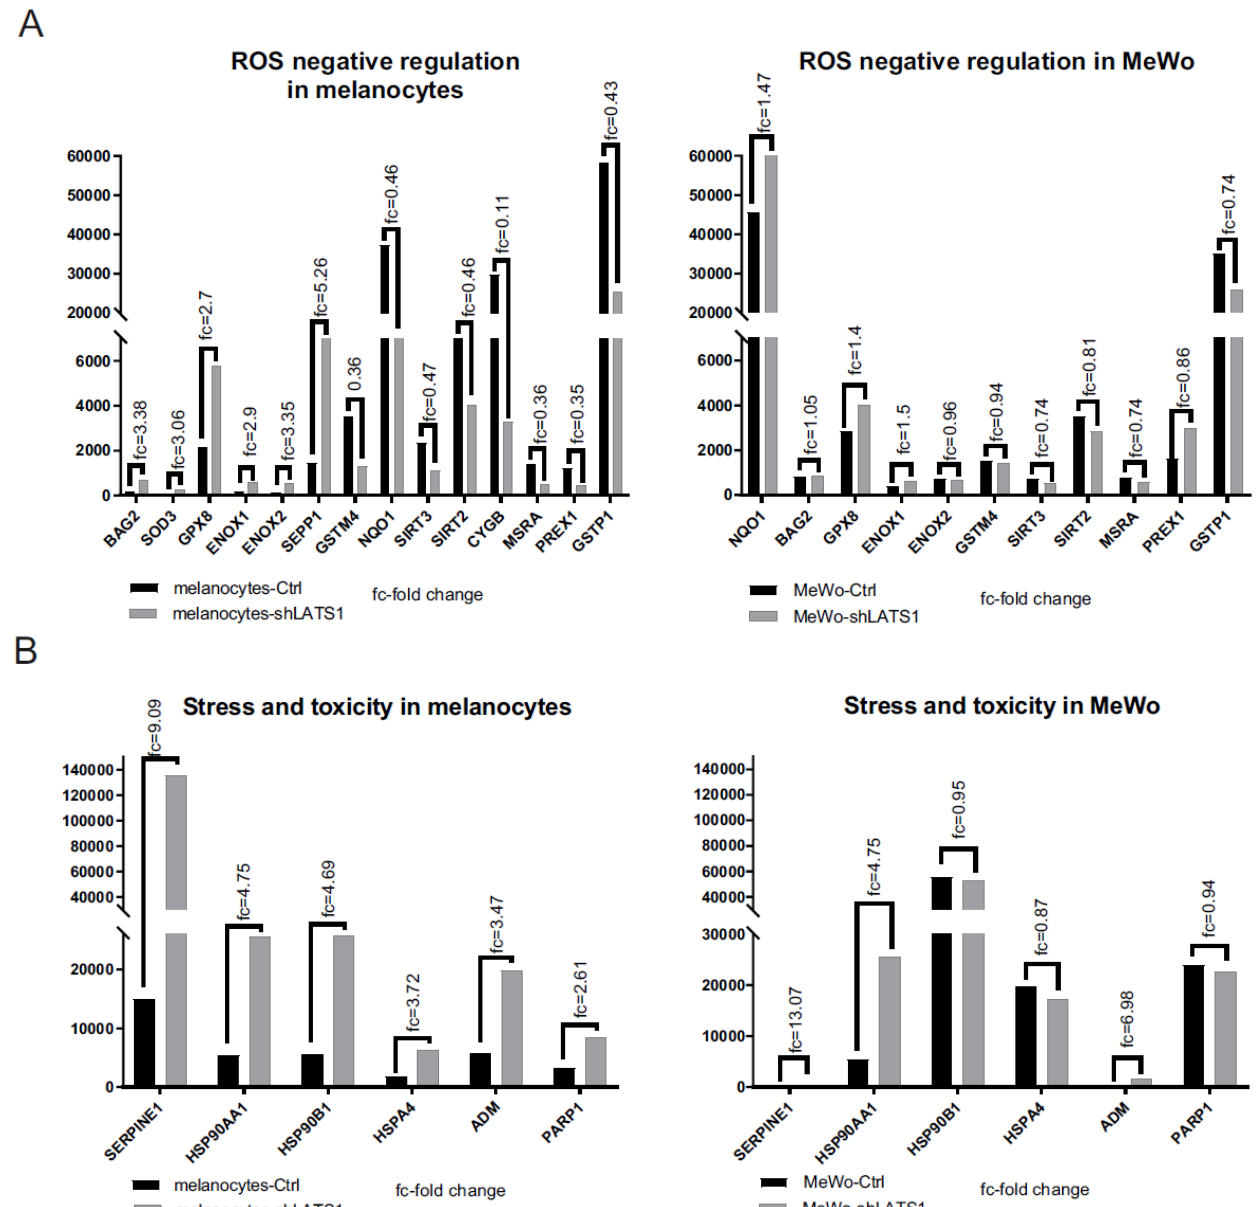
Figure 4. Expression of oxidative stress and toxicity markers following LATS1 knockdown. Comparison of the expression of the genes negatively regulating oxidative stress ( A ) and stress and toxicity markers ( B ) in primary melanocytes (left) and MeWo cells (right), with fold changes of normalized expression values. black bars represent cells with regular LATS1 expression; grey bars represent cells with LATS1 knocked down.